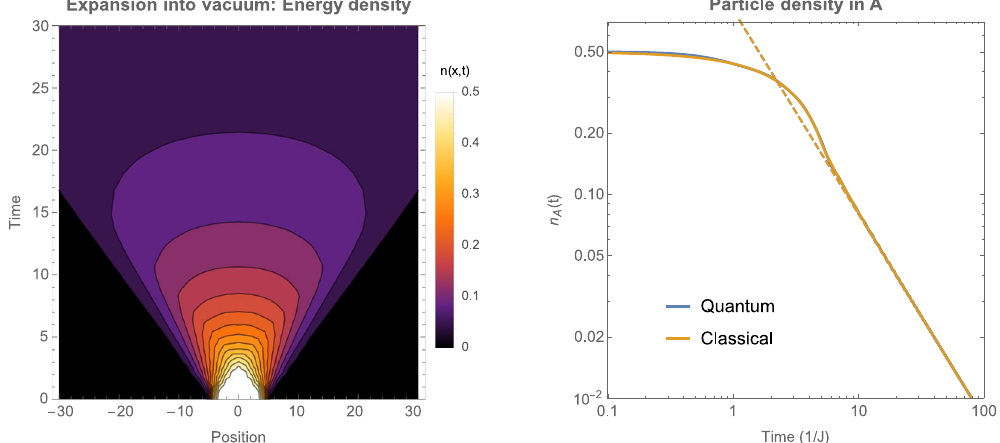
Figure 1. Expansion of an atomic cloud into the vacuum. Initially we prepare an one-dimensional atomic cloud in region A (| x | < 5), at inverse temperature β = 0.01, with particle density n = 0.5. On the left we show the energy density as a function of position x and time t , following exact quantum evolution. On the right we show the density of particles n A ( t ) in region A . The full quantum evolution is correctly represented by a classical distribution of particle positions and velocities n ( x , v , t ) whose time evolution is given by ballistic motion, n ( x , v , t ) = n ( x − vt , v , 0). At late times, the particle density in region A decays as n A ~ 1/ t , in the right graph shown as a dashed